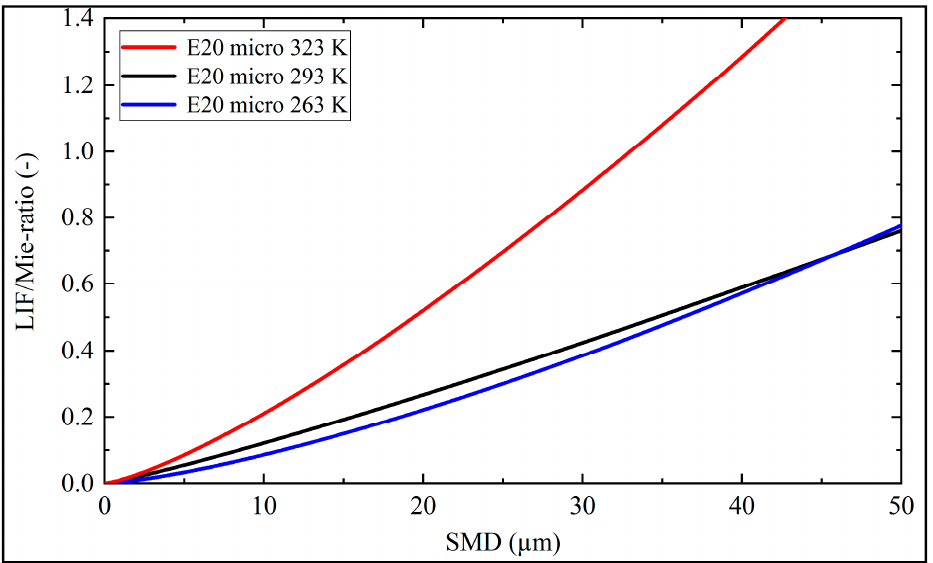
Figure 9. E ff ects of liquid temperature on the LIF / Mie ratio at a constant dye concentration (100 mg / L Figure 9. Effects of liquid temperature on the LIF/Mie ratio at a constant dye concentration (100 mg/l nile red) in E20, 293 nile red) in E20, 293 K.